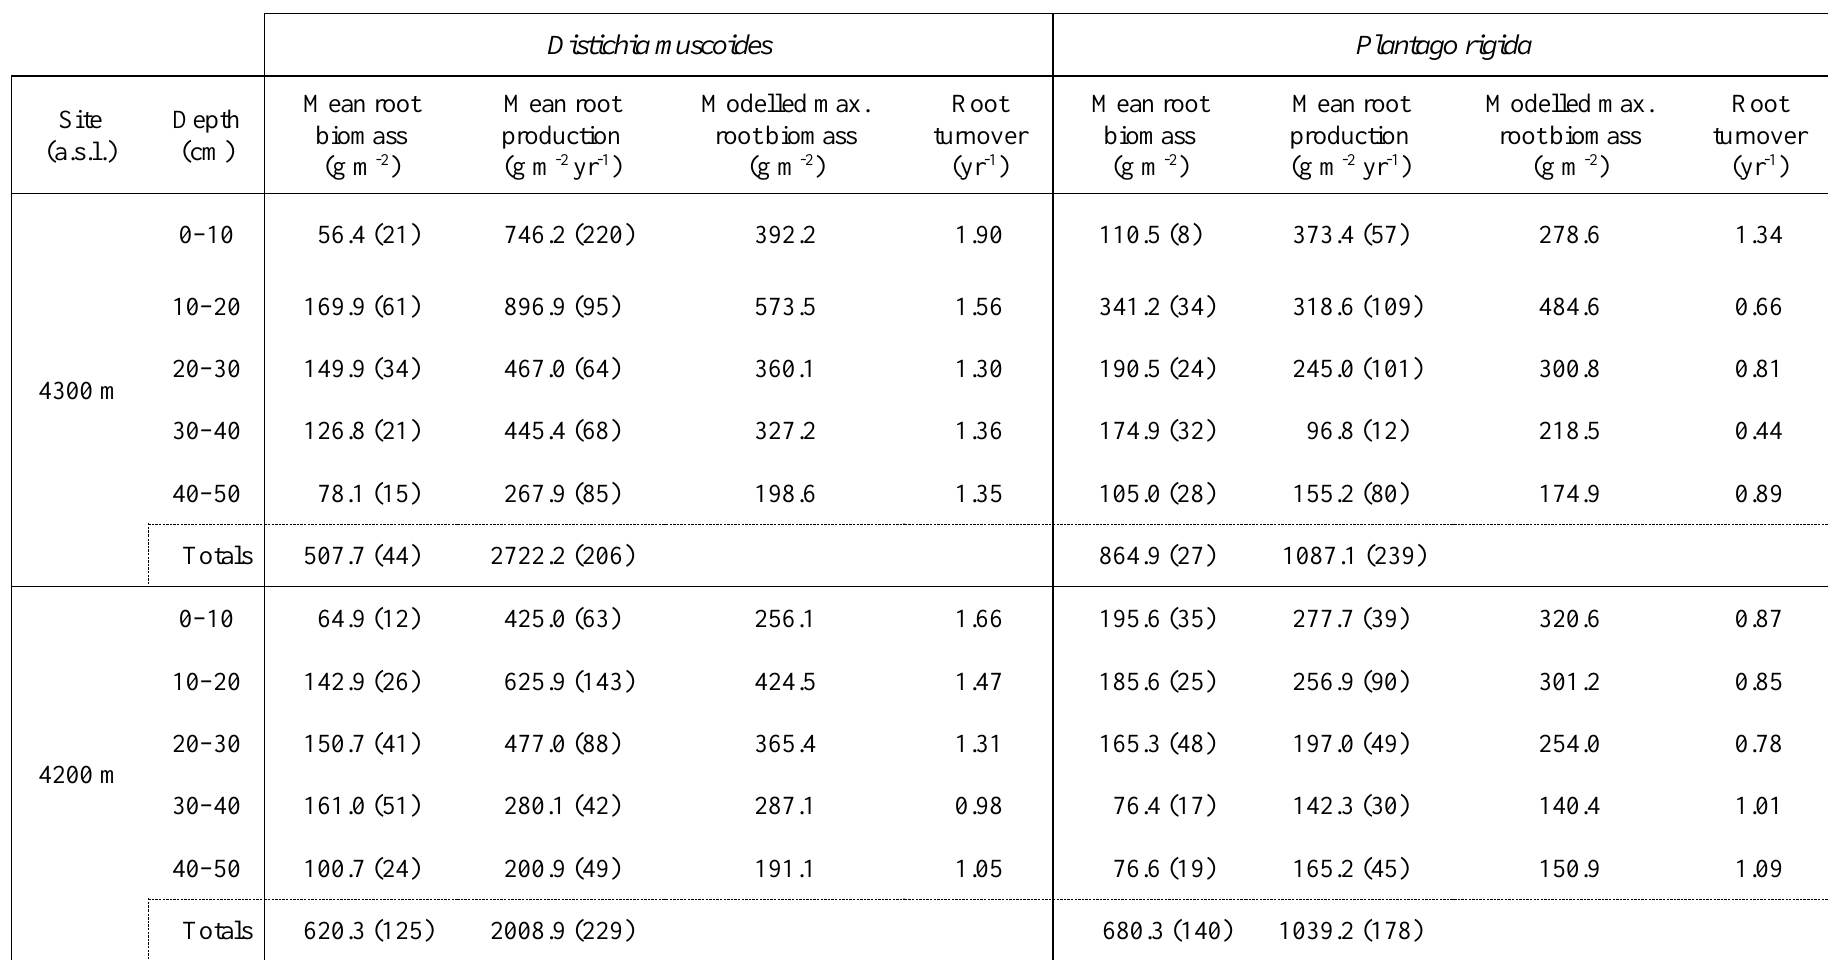
Table 1. Mean root standing stock, root production, and root turnover rate in cushion plants of Distichia muscoides and Plantago rigida at two peatland sites at different elevations (4200 and 4300 m a.s.l., respectively) in the páramos of Northern Ecuador. Numbers in parentheses: standard error of the mean. For biomass, four samples were taken from each species at each site. For root production, nine ingrowth bags were installed for each species at each